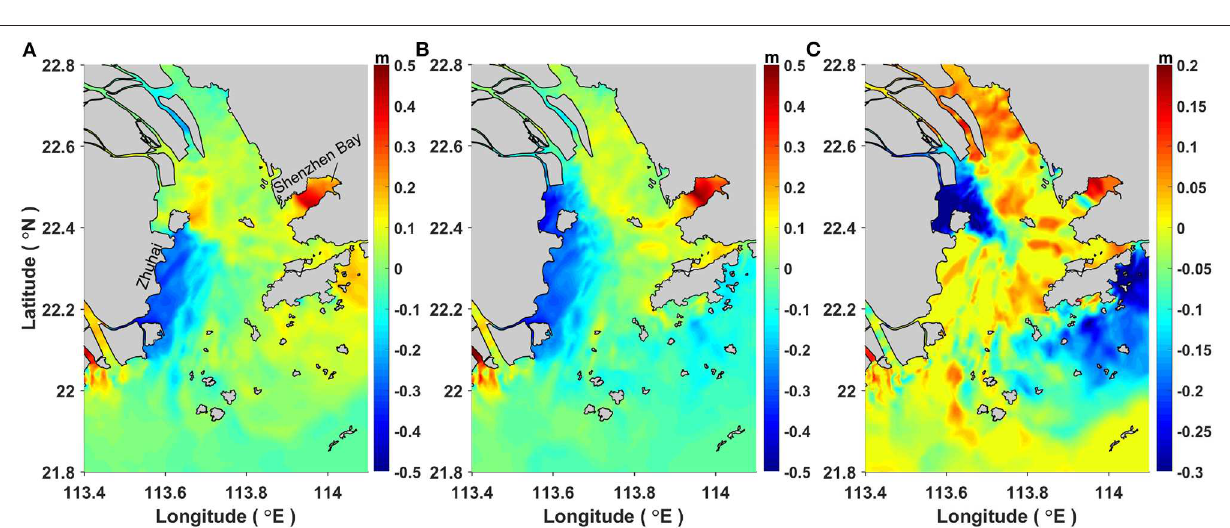
FIGURE 6 | Time series of storm tides ( ζ ST ), pure astronomical tides ( ζ TO ), pure storm surges ( ζ SO ), practical storm surges ( ζ PS ), and residual elevations due to the tide-surge interaction ( ζ